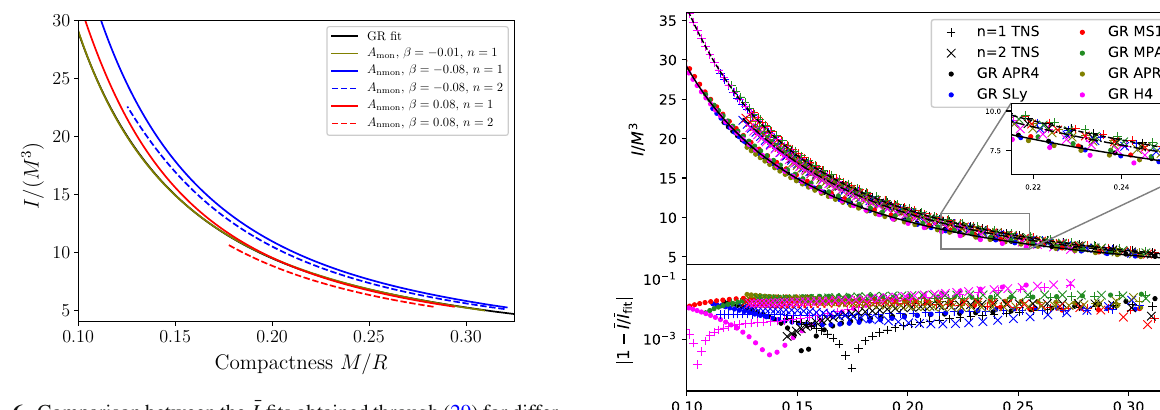
Fig. 6 Comparison between the ¯ I fits obtained through (29) for differ- ent theory parameters considered. The olive curve is that obtained for the monotonic coupling function (12) while the remaining four curves show the qualitative difference in results for positive and negative beta in the case of non-monotonic coupling (11)